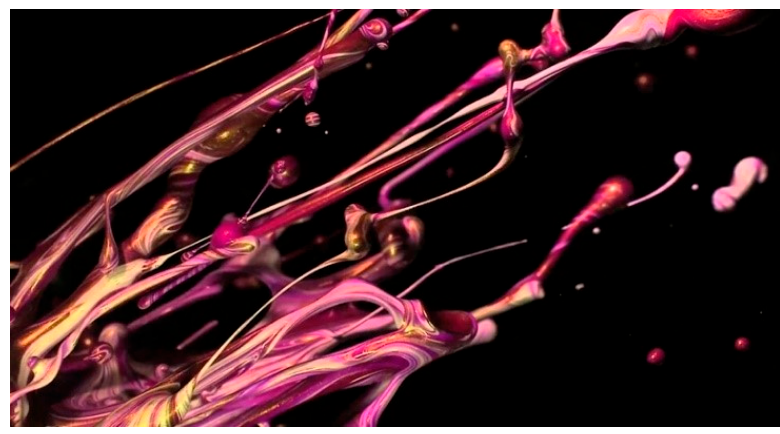
Figure 9. A scene from “Sound of Ikebana”.